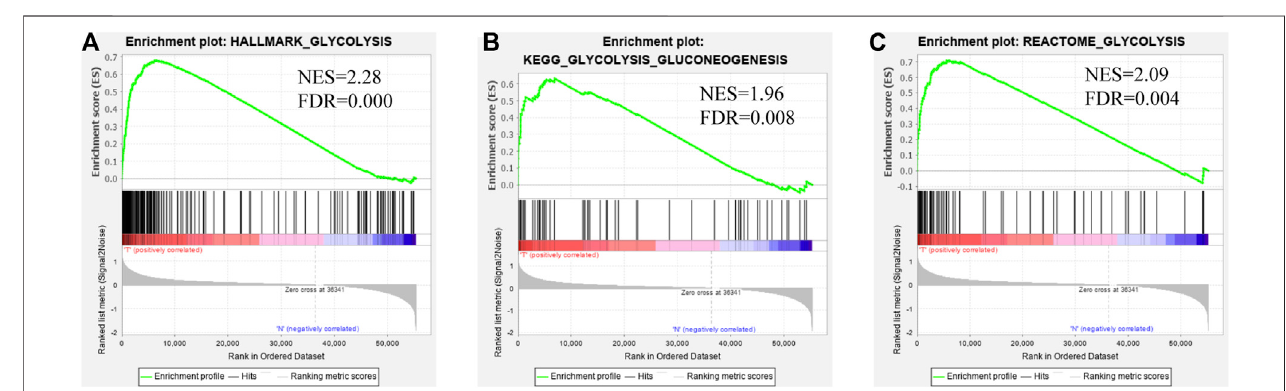
FIGURE 2 | Enrichment plots of three glycolysis-related gene sets which were signi fi cantly differentiated between normal and EC tissues using GSEA. (FDR is the corrected p value of the multiple hypothesis test, NES stands for normalized enrichment score) (A) . Glycolysis-related HALLMARK gene sets (B) . Glycolysis-related KEGG gene sets (C) . Glycolysis-related REACTOME gene